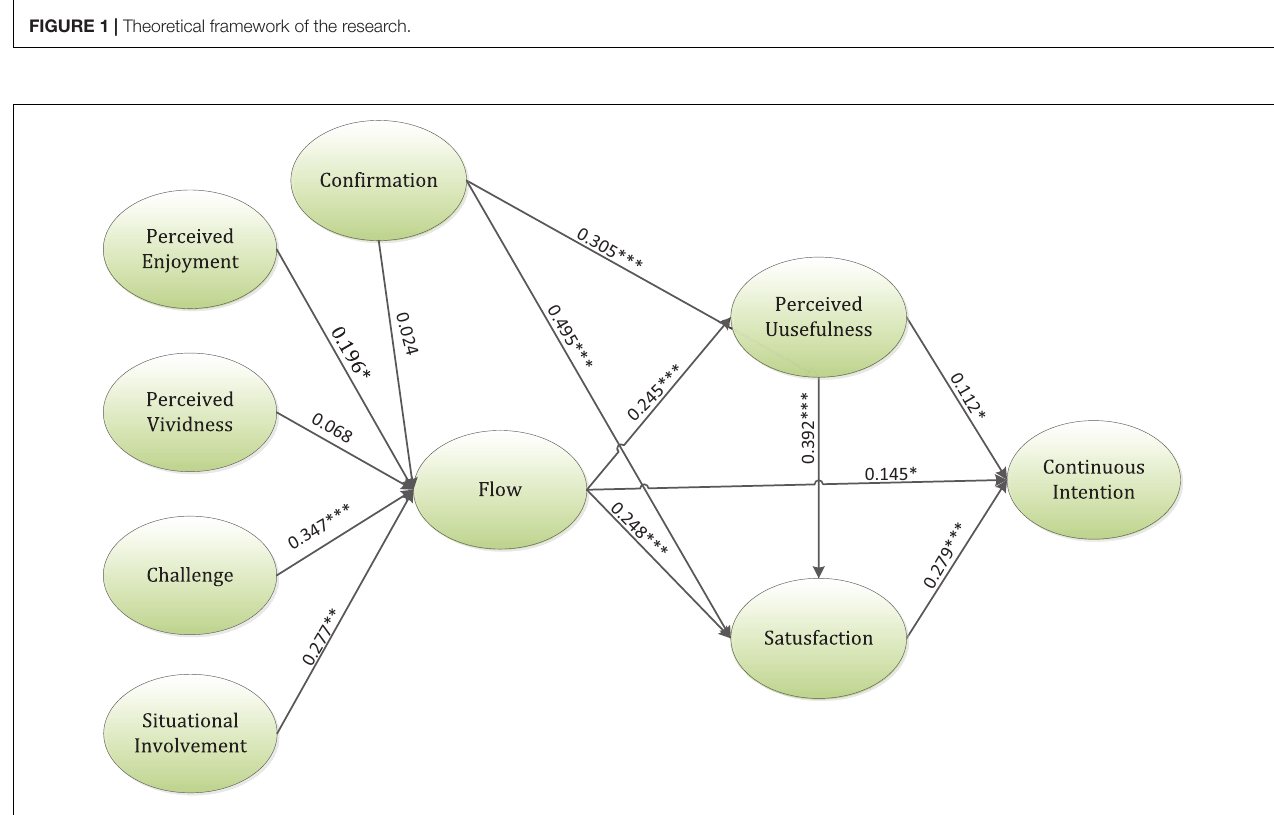
FIGURE 2 | A framework of the inner model result. * p ≤ 0.05, ** p ≤ 0.01, *** p ≤ 0.001.